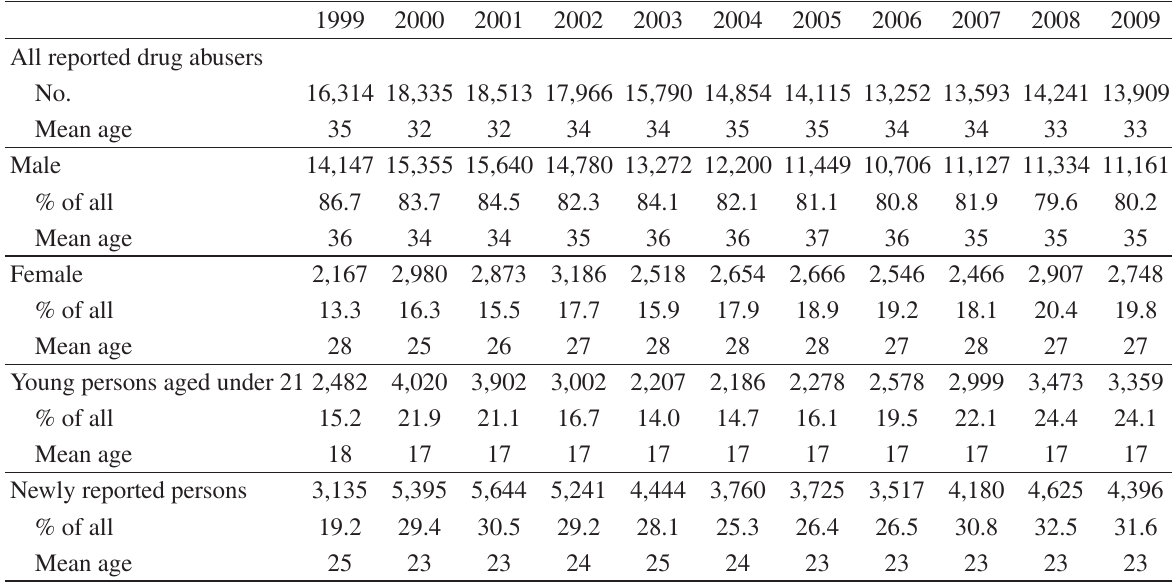
TABLE 1: Trends of substance abuse in Hong Kong based on the Central Registry on Drug